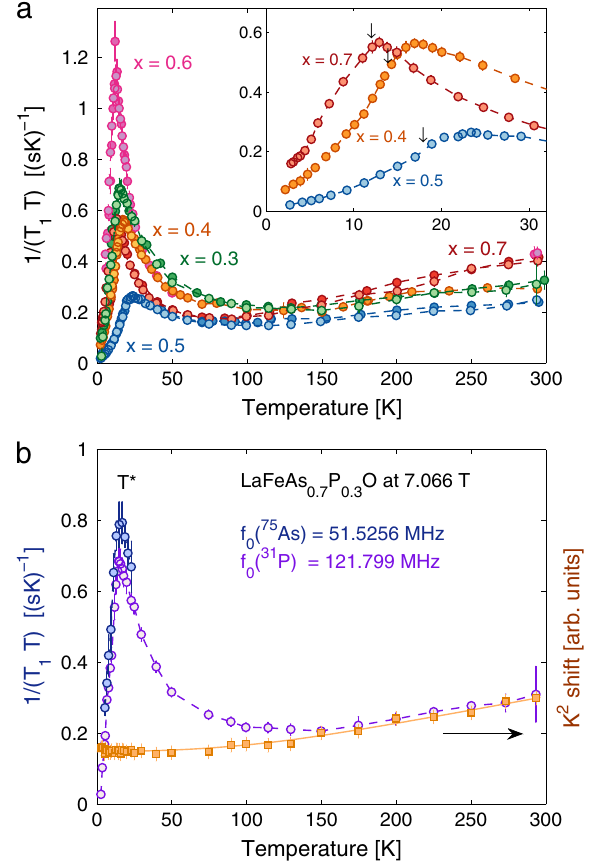
Fig. 6 Peak in 1/ T 1 T hints at signi fi cant spin fl uctuations, as con fi rmed by comparison with Knight-shift data. a 1/( T 1 T ) vs. temperature for all the samples. While the datasets at 3.5 and 7 T for the same sample coincide, the height and position of maxima depend strongly on x . Inset: Below T c (arrows) the lowest 1/( T 1 T ) value is achieved for the sample with the highest T c ( x = 0.5). b Left scale (circles): 1/( T 1 T ) vs. temperature in LaFeAs 0.7 P 0.3 O measured via 31 P and 75 As NMR at 7.066 T. In spite of the very different Larmor frequencies, the comparison shows closely matching features and similar 1/( T 1 T ) magnitudes. Given the absence of quadrupole effects for the I = 1/2 31 P nucleus, this similarity hints at a magnetic origin of nuclear relaxation, i.e., related to AF electron-spin fl uctuations. Right scale: A comparison of the temperature dependences of 1/( T 1 T ) (circles) and 31 K 2 (squares). The signi fi cant departure of the two curves below ca. 120 K indicates the development of strong AF fl uctuations